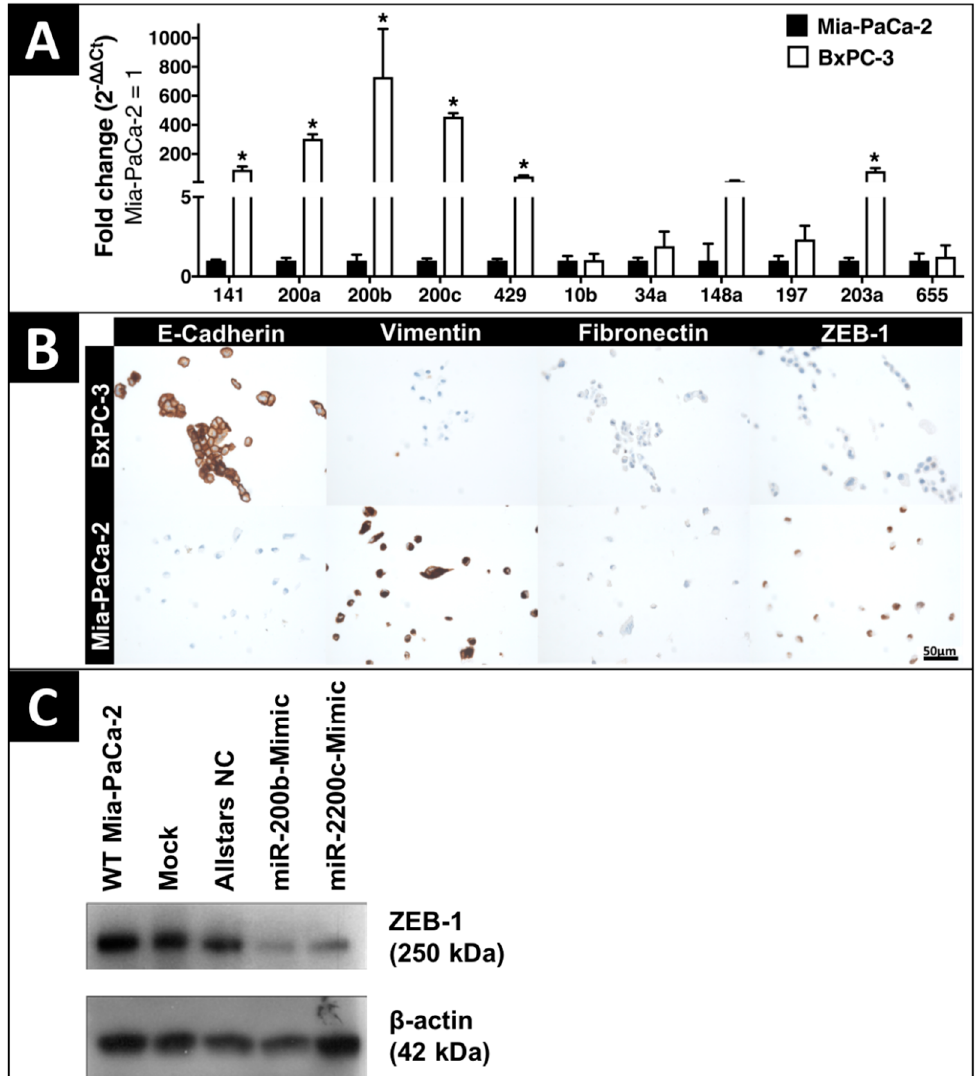
Figure 1. Expression of EMT-regulating microRNAs and EMT-proteins in-vitro. ( A ) EMT-regulating microRNA expression by qRT-PCR in mesenchymal human pancreatic ductal adenocarcinoma (PDAC) cell line Mia-PaCa-2 and epithelial BxPC-3. Fold change values interpreted with the ΔΔ Ct-method and data expressed as mean ± Standard error of the mean (SEM) ( n = 3). * indicates significance ( p ≤ 0.05) against Mia-PaCa-2. ( B ) Immunohistochemistry (IHC) staining of E-Cadherin, Vimentin, Fibronectin and ZEB-1 (Zinc finger E-box-binding homeobox) in human PDAC cell lines Mia-PaCa-2 and BxPC-3. Scale bar: 50 μ m. ( C ) EMT-marker protein expression of ZEB-1 by Western blot in mesenchymal wild type (WT) Mia-PaCa-2 after transient transfection with microRNA-200b and -200c